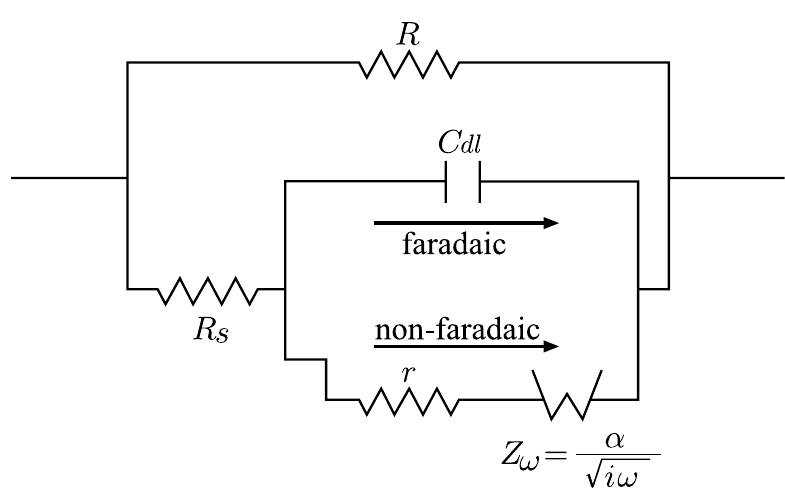
Fig. 9 – Reproduction of Dias’ model based on an analog fundamental circuit.